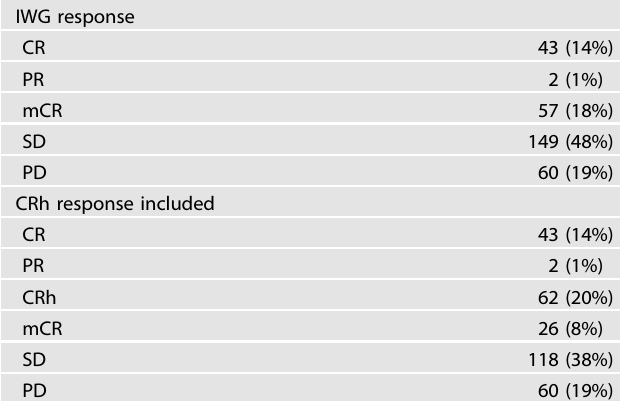
Table 2. Responses to azacitidine or decitabine according to IWG 2006 response criteria or modi fi ed criteria to include